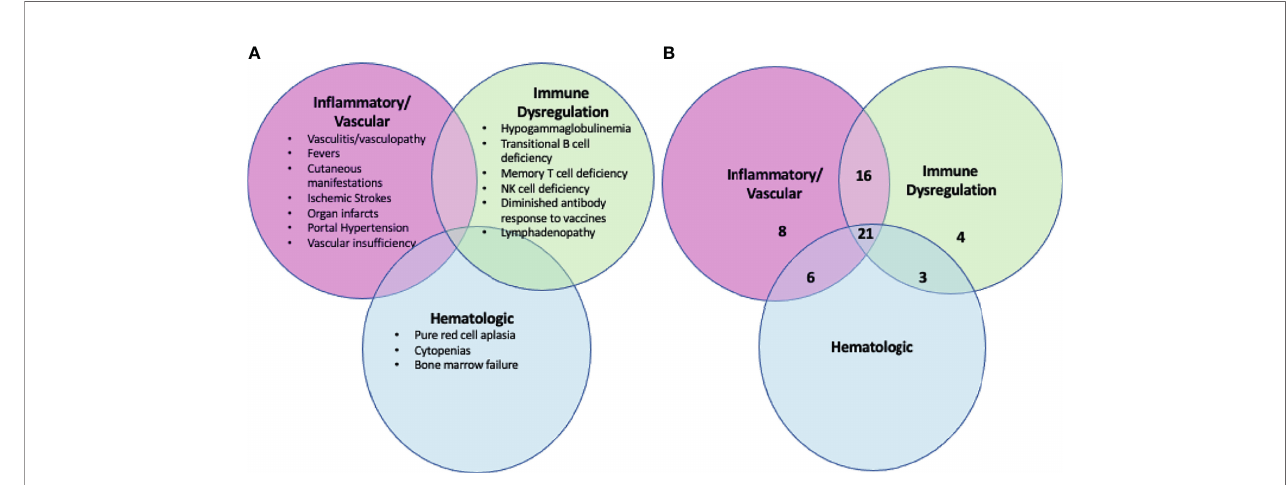
FIGURE 1 | The clinical manifestations of DADA2 are broad and not exclusive. (A) Summary of the clinical manifestations of DADA2, including in fl ammatory, immune dysregulation and hematologic abnormalities. Patients with DADA2 may exhibit any combination of these abnormalities. (B) Breakdown by phenotype of the 58 individuals enrolled in the NIH cohort. The numbers re fl ect the number of individuals in the NIH 58 patient cohort who fall into each phenotypic zone. Forty-six of the 58 individuals have clinical manifestations that span more than one of the broader classes (in fl ammatory, immune dysregulation,